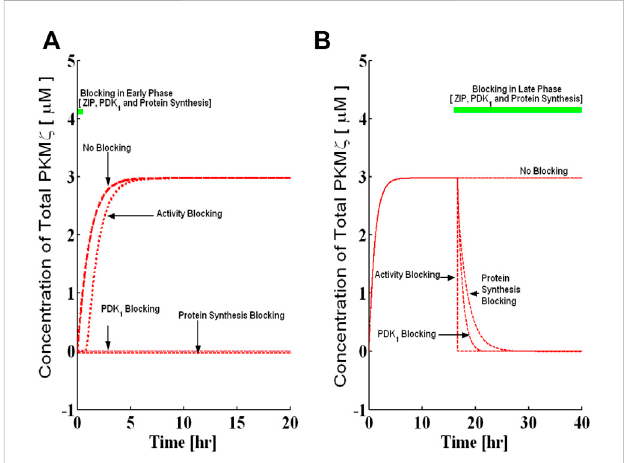
FIGURE 6 Blocking the protein synthesis in the early and late phases and its comparison with the PDK1 and PKM ζ activity block. Simulations are implementedwithand withoutproteinsynthesis pulse U. Abrief pulse of protein synthesis is used to mimic the induction of L-LTP by applying a high-frequency stimulus. The solid blue line represents the PKM ζ concentration at basal levels of protein synthesis (without the application of pulse), and the dashed red line represents the PKM ζ concentration with the application of a protein synthesis pulse. (A) Complete block of protein synthesis during induction for 15 min (solid green line shows blocking time). Complete blocking of protein synthesis during the early phase completely abolishes the induction phase of L-LTP. (B) Blocking the protein synthesis during maintenance for 90 h (solid green line shows blocking time). The complete protein synthesis blockingduringmaintenanceslowlyreversestheestablishedL-LTPfrom theuptothedownstate.ComparedtothePKM ζ andPDK1activityblock, the protein synthesis blocking reversed the established L-LTP on a slower